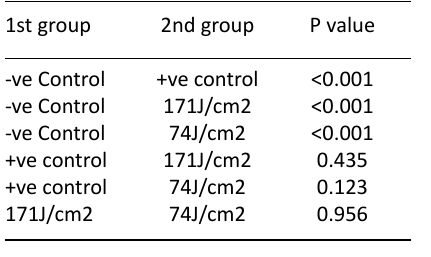
Fig. 2. Edema caused by carrageenan injection in TMJ area Table 8. Head circumferences comparison in day zero between every pairs